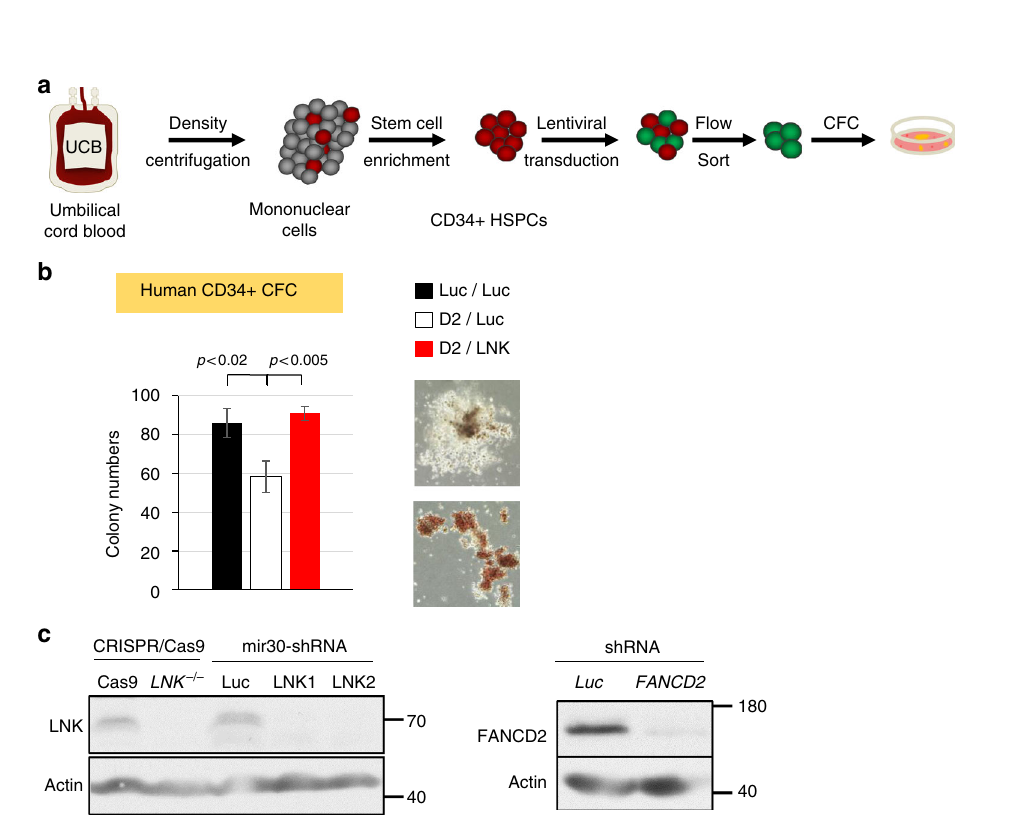
Fig. 6 Lnk de fi ciency stabilizes stalled replication forks in Fancd2 − / − HSPCs through cytokine-JAK2 signaling. a, b BM cells from WT, D2 − / − and D2 − / − L − / − mice were plated in semi-solid methylcellulose media containing HU that induces replication stress ( a ) or indicated ICL DNA damage-inducing drugs, MMC, cisplatin, formaldehyde ( b ). Colony forming progenitor numbers relative to the vehicle-treated group (mean± SE) were enumerated and graphed. Representatives of three independent experiments are shown. Statistics were calculated using two-tailed Student ’ s t -test. ( c ). The top panel shows the experimental overview of the fork protection assay in single-molecule DNA fi bers upon HU-mediated replication stalling. c , d Freshly isolated HSPCs (LSKs) from WT, D2 − / − , Lnk − / − , and D2 − / − Lnk − / − (D2 − / − L − / − ) mice were subjected to fork protection assay. The frequencies of different replication tract ratios are plotted in ( c ). The distributions of CldU/IdU fi ber ratios are shown in ( d ). e Splenic B cells were cultured in RP-105 and LPS with (Left) or without IL-4 (Right), then subjected to fork protection assay. ( f ) HSPCs from WT, D2 − / − , and D2 − / − L − / − BMs were cultured in cytokines then subjected to the fork protection assay. 0, 1, or 2 µ M JAK inhibitor ruxolitinib (JAKi) along with MRE11 inhibitor Mirin or vehicle alone were administered during the HU incubation in the fork protection assay. d – f The distribution of CldU/IdU fi ber ratios is shown with the horizontal lines indicating geometric mean of fi ber ratios, with corresponding number for each group shown at the bottom of the graph. a – c P values from two-tailed Student's t -test are shown. d – f Statistical signi fi cance of each set of conditions was calculated using Kruskal – Wallis ANOVA test and comparisons between individual groups were calculated using